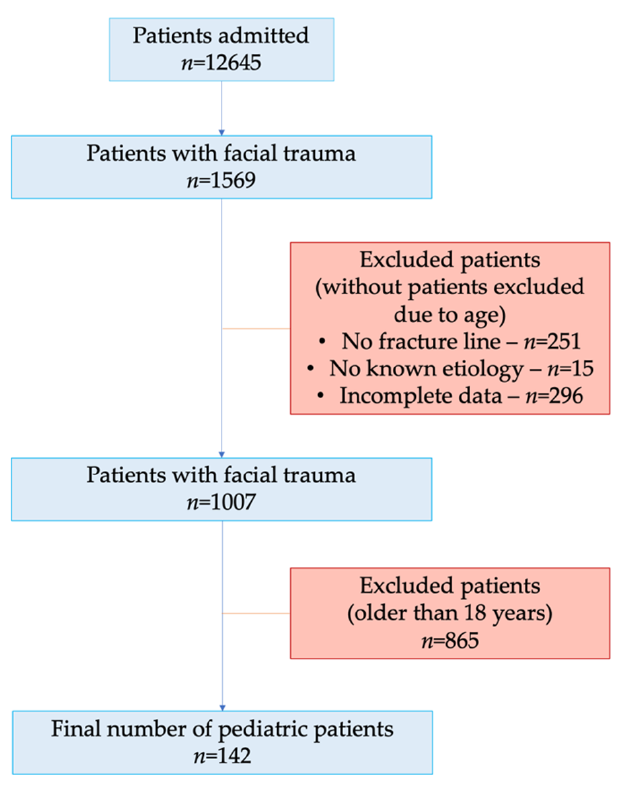
Figure 1. Study Figure 1. Study flowchart.